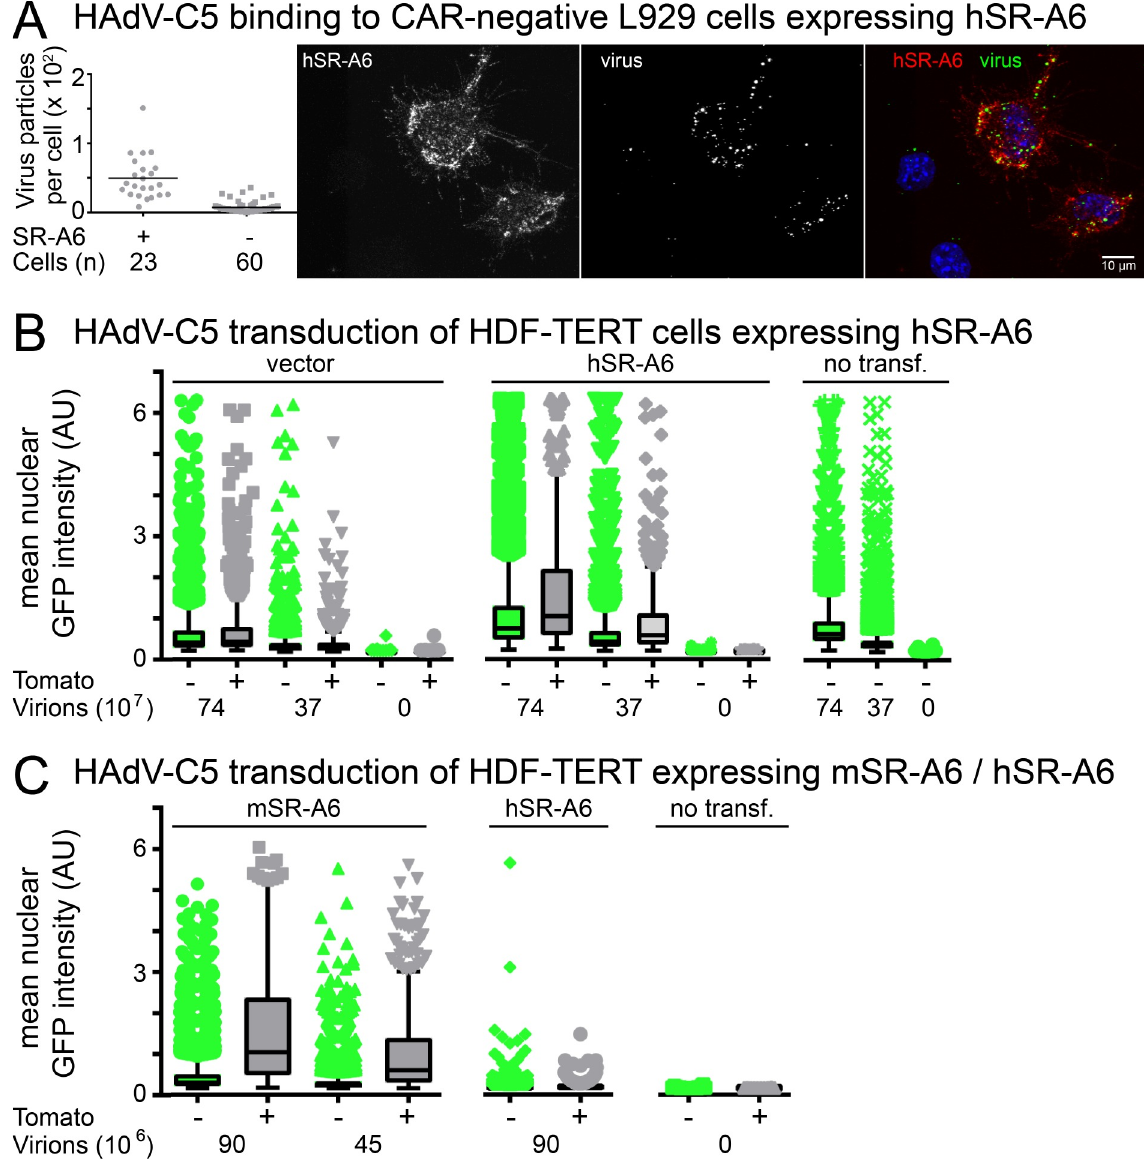
Fig 6. High surface expression of human SR-A6 facilitates HAdV-C5 infection. A) Exogenous expression of human SR-A6 in L-929 cells (low CAR expression) promotes binding of HAdV-C5 to the cells. L-929 cells were transfected with a plasmid directing the synthesis of human SR-A6 from the cytomegalovirus major immediate early promoter and transfected cells were identified by immunostaining with anti-human SR-A6 antibody PLK1. Alexa-Fluor488-labeled HAdV-C5 particles were added to transfected L-929 cells at 4˚C for 60 min. Fixed samples were imaged by confocal microscopy and virus particles associated with PLK1-positive and PLK1-negative cells were scored from maximum projections of confocal stacks. The plot shows number of virus particles per cell, one dot representing one cell. Horizontal bars represent mean values. Number of cells analyzed is indicated. The difference between PLK1-positive and -negative cells was statistically highly significant (P < 0.0001, Kolmogorov-Smirnov test). The right-hand panel shows a representative image as a maximum projection of confocal stacks. In the overlay panel virus particles are shown in green, SR-A6-positive cells in red and nuclei (DAPI) in blue. Scale bar = 10 μm. B) Exogenous expression of human SR-A6 in HDF-TERT cells boosts HAdV-C5-mediated gene transduction. SR-A6 was expressed in the cells from a plasmid that directed synthesis of the protein from a bi-cistronic SR-A6-IRES-Tomato mRNA. Transfected HDF-TERT cells were infected with two different amounts of HAdV-C5_dE1_GFP, and nuclear GFP signals were scored at 30 h post infection (pi) by microscopy. Non-transfected cells or cells transfected with an empty vector were used as controls. The mean nuclear GFP intensities of Tomato-positive and Tomato- negative cells are shown as Tukey box plots. The difference between Tomato-positive and Tomato-negative cells in the SR-A6 transfection was statistically highly significant with a P-value < 0.0001 (Kolmogorov-Smirnov test), whereas the difference in empty vector transfections did not reach P < 0.0001 significance levels. Over 300 Tomato-positive cells and more than 5000 Tomato-negative cells were scored for each sample. C) Mouse SR-A6 expression in HDF-TERT cells leads to higher HAdV-C5_dE1_GFP infection efficiency than human SR-A6 expression. Both